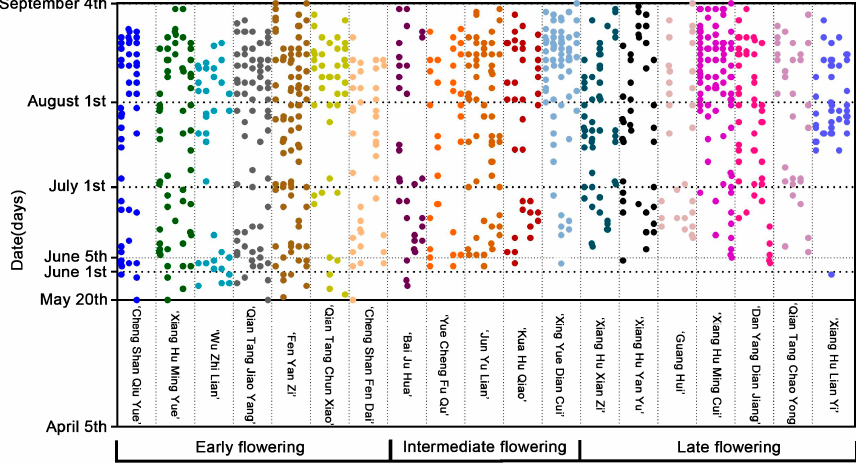
Figure 1. Sca tt er plots of blooming time of 19 cultivars in 2020.